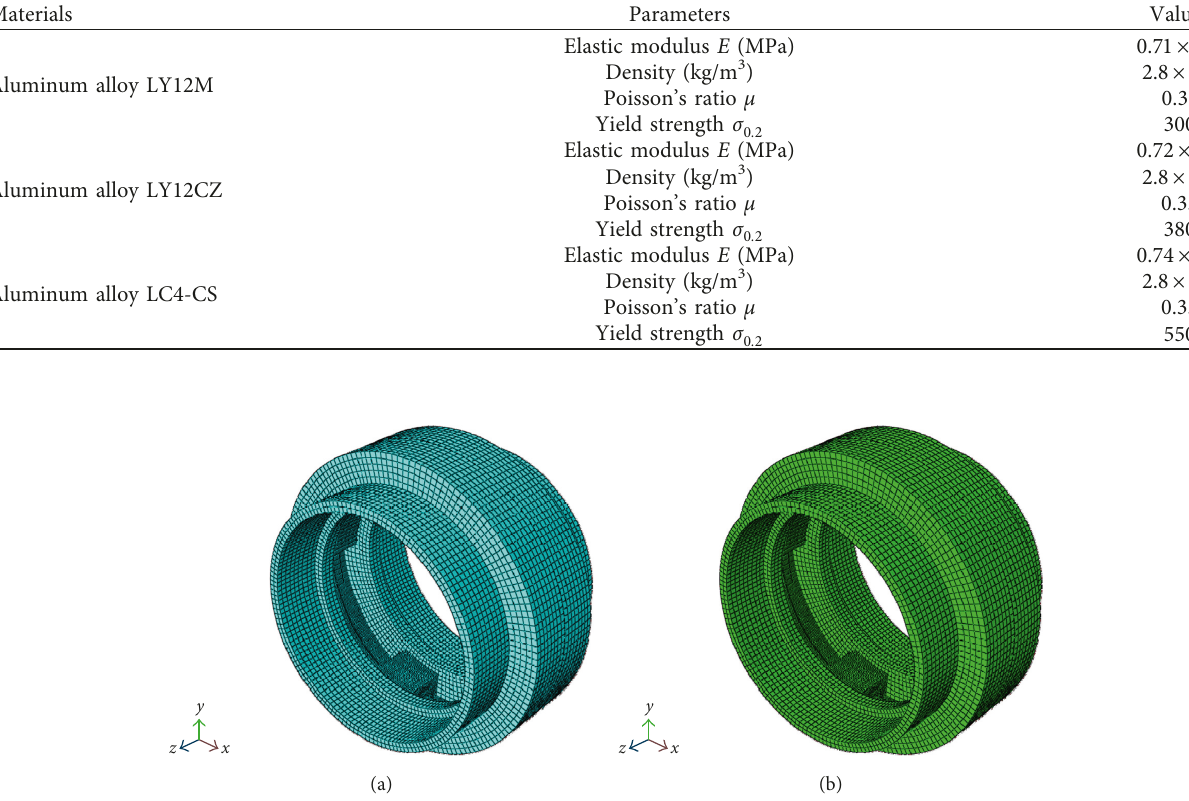
Figure 20: Joint models with different materials. (a) Aluminum alloy LY12CZ joint model. (b) Aluminum alloy LC4-CS joint